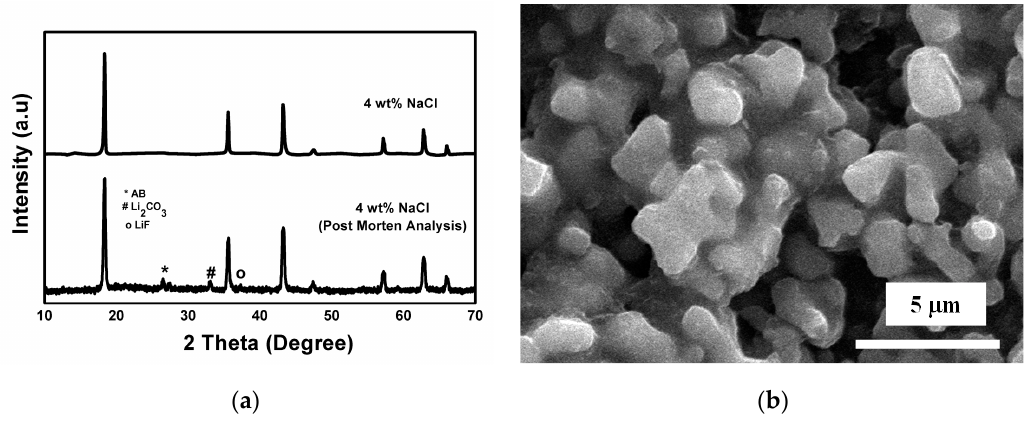
Figure 6. Post cycle of LTO-4 wt % NaCl after 1000 cycles by ( a ) XRD and ( b ) SEM.